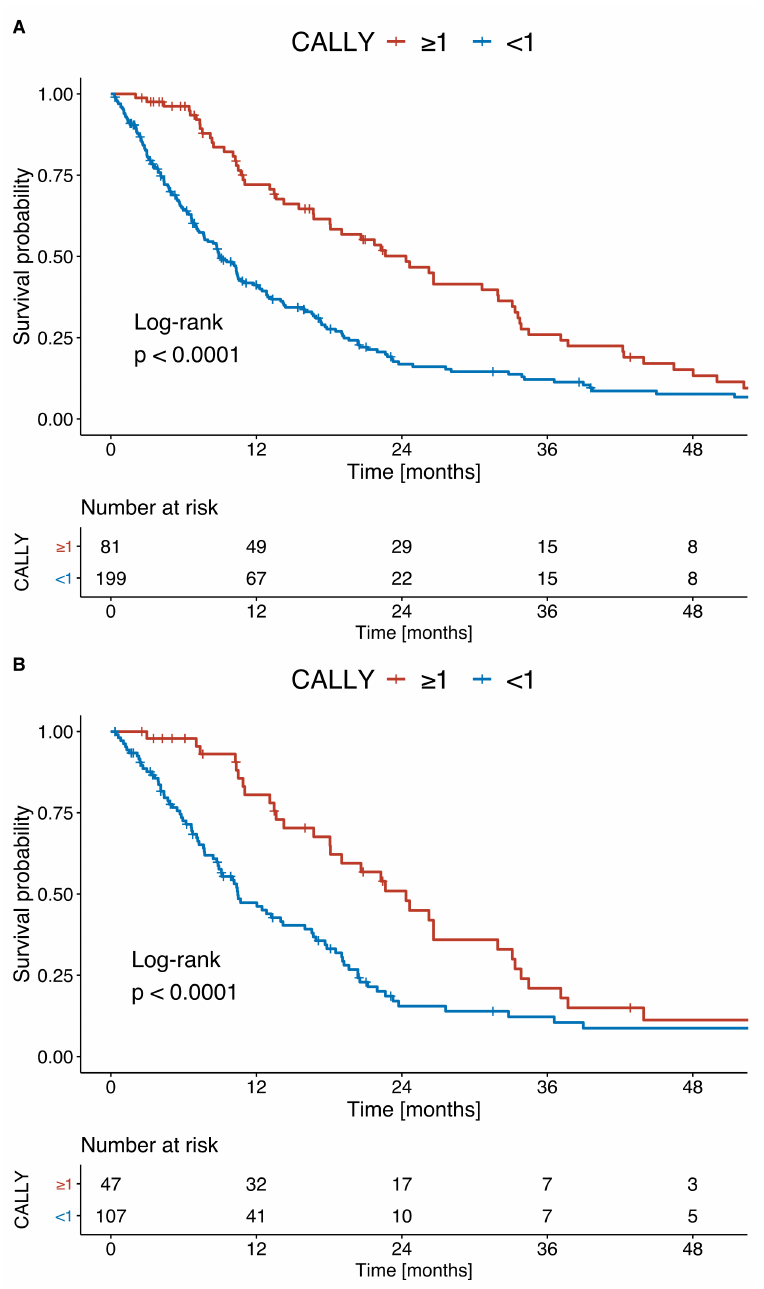
Figure 3. Kaplan–Meier survival curves comparing patients with low and high CALLY scores among ( A ) all patients and ( B ) patients classified as BCLC